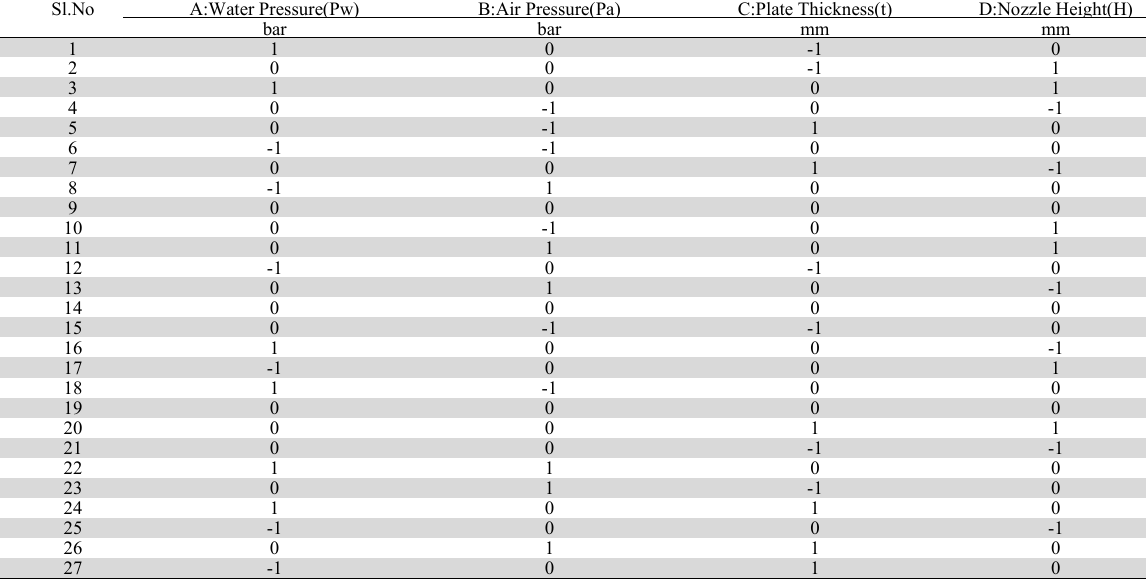
Box Behnken RSM based Coded Experimental Design Matrix